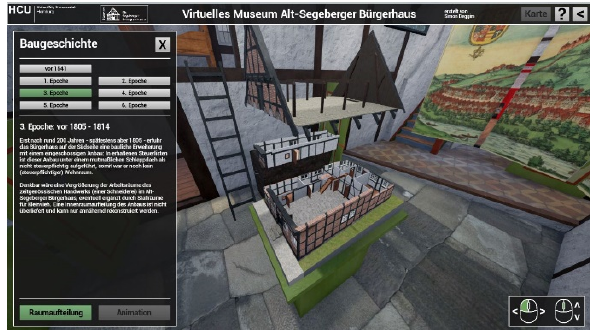
Figure 5. Information menu in the Virtual Museum of the Alt- Segeberger Bürgerhaus demonstrating the six construction phases in an